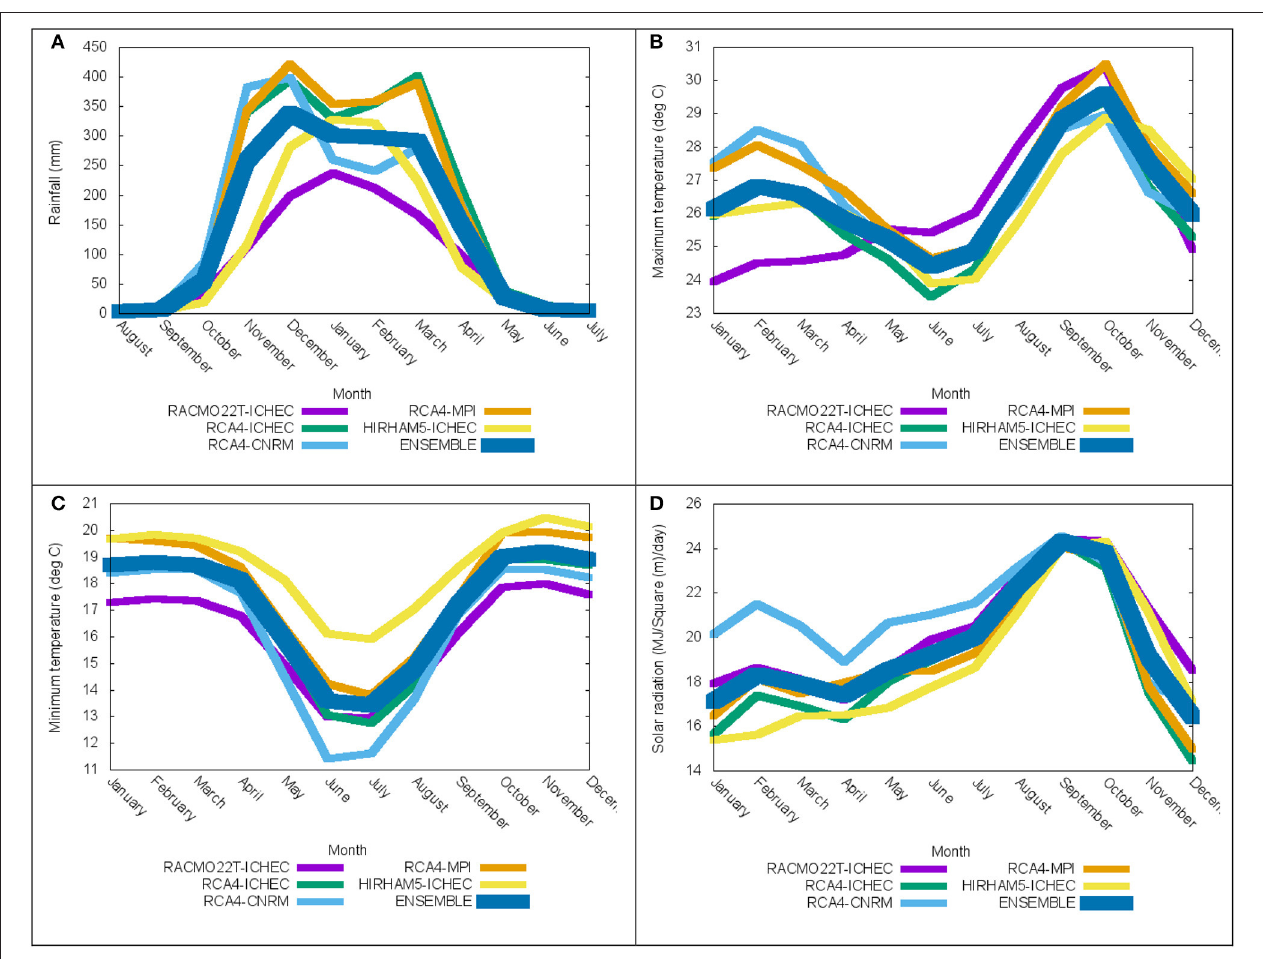
FIGURE 4 | Long-term (2040–2069) annual cycle of climate variables over southern and western highlands sub-agro ecological zones of Tanzania under RCP8.5 (A) rainfall, (B) maximum temperature, (C) minimum temperature, and (D) Solar